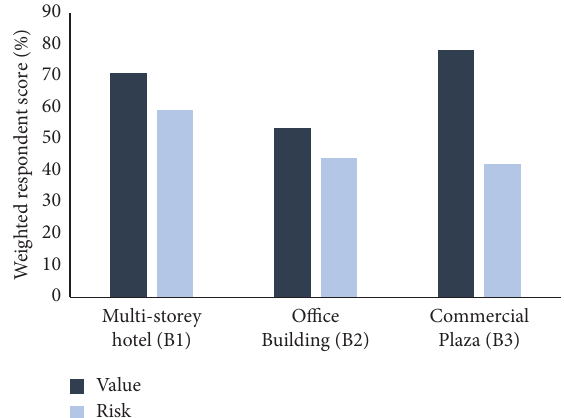
Figure 5: Comparison of three diferent types of buildings in terms of value-added and risk impacts in the design